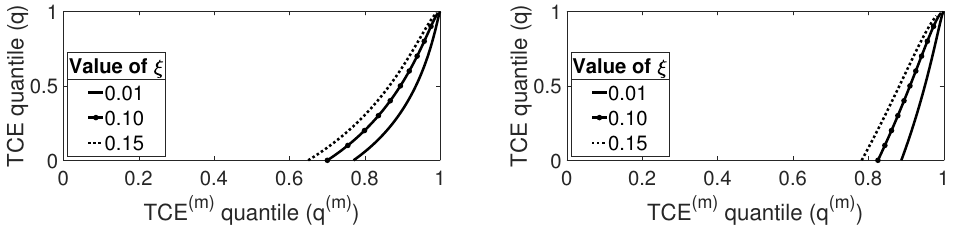
Figure 11. TCE quantile as a function of extended TCE quantile at order m = 2 with σ = 0.1. ( Left panel ): µ = − 0.05. ( Right panel ): µ = +